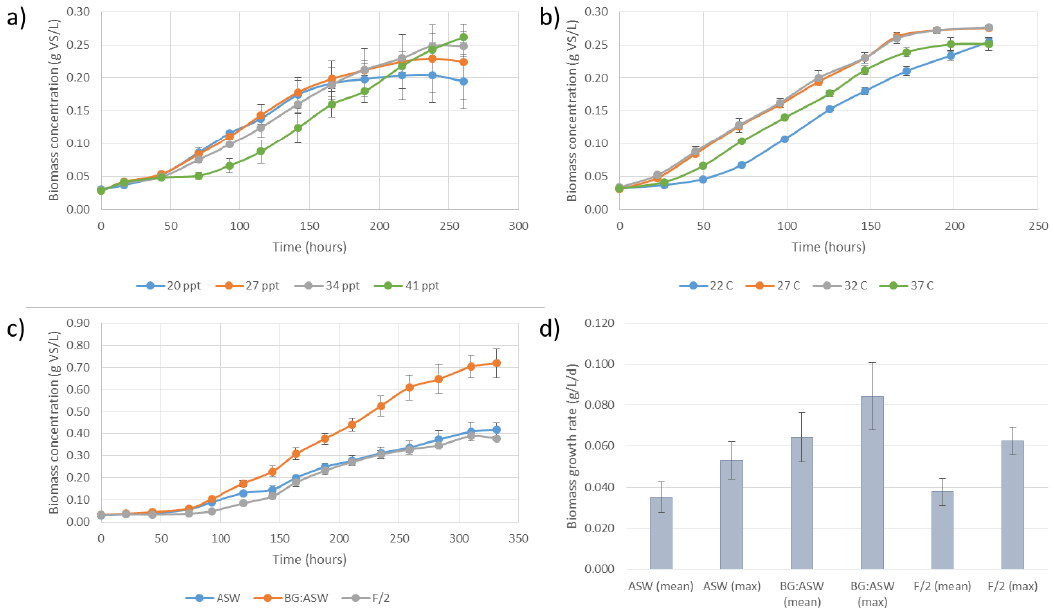
Figure 1. Growth characterization for a Synechococcus strain local to Abu Dhabi: ( a ) Salinity tolerance assay, ( b ) temperature tolerance assay, ( c ) media composition growth assay, and ( d ) comparison of daily biomass growth rates for different media formulations (with maximum and minimum readings).